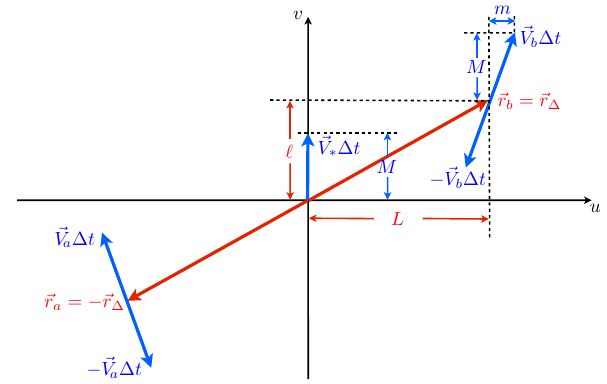
Fig. 1. Geometry of the planar four-point configuration generated by moving satellites a and b